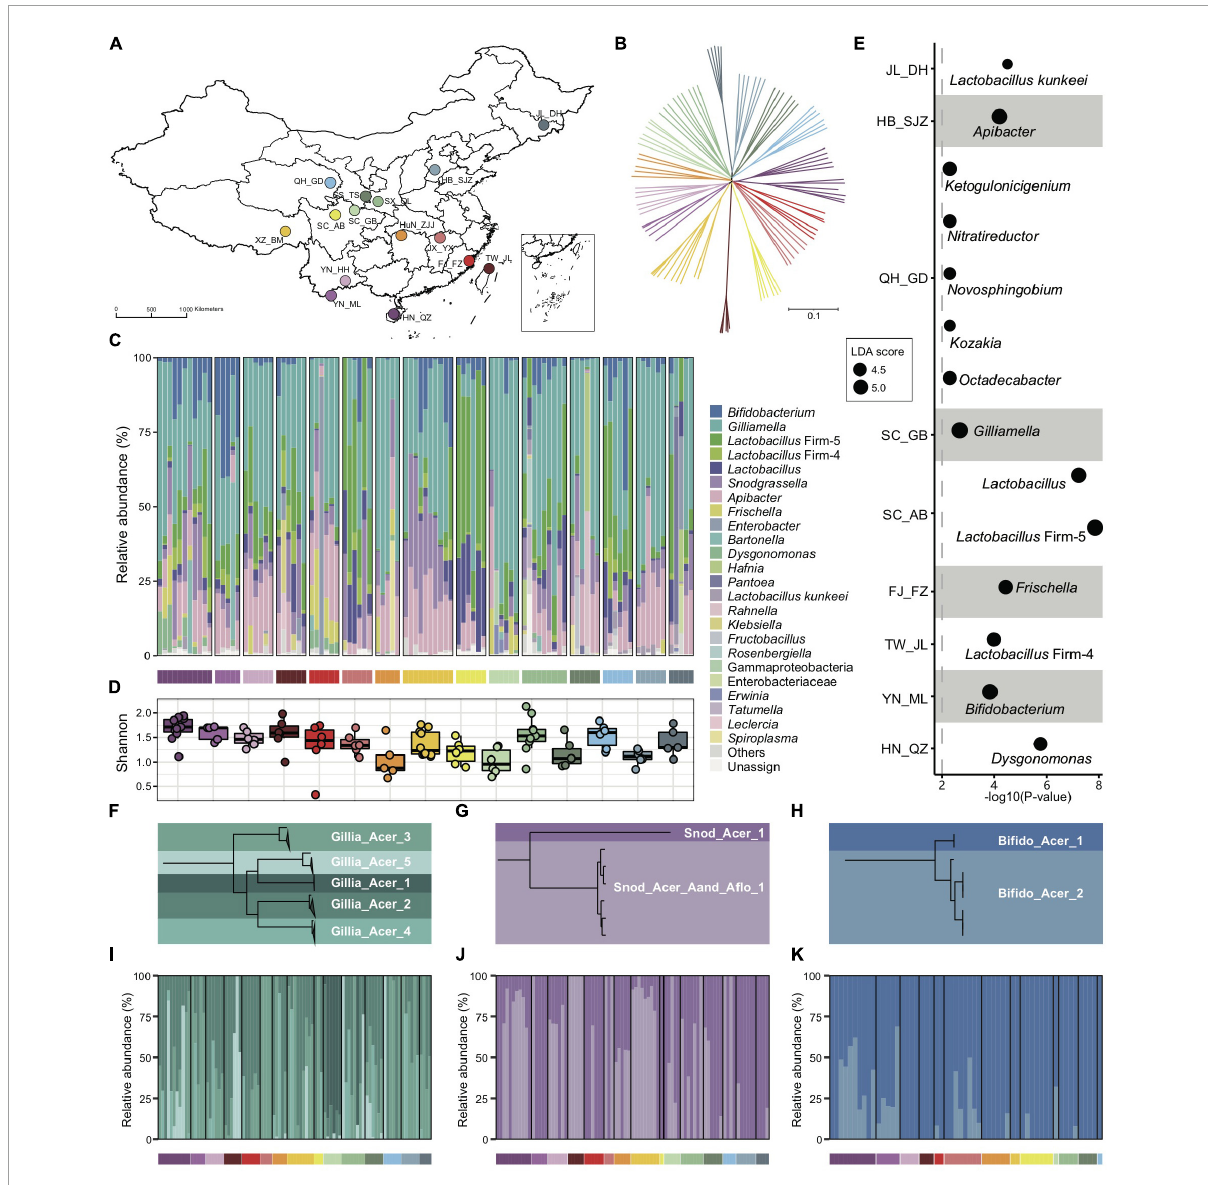
FIGURE1 Bacterial composition of gut microbiota in geographic populations of Apis cerana . (A) Sampling sites of 15 A. cerana geographic populations. (B) Neighbor-joining tree reflecting the honeybee population structure, based on genome-wide SNPs. Bacterial relative abundance (C) and Shannon index (D) are based on gut metagenomes of different populations. Phylotypes with at least 5% abundance in any sample or 0.5% abundance in more than 6 samples were shown, otherwise included in “Others.” Lactobacillus : Lactobacillus that is not assigned to any known groups. (E) Featured gut microbe phylotypes in each geographic population were revealed by LEfSe analyses. The size of the bubbles represents LDA score. Phylogenetic relationships of SDPs within Gilliamella (F) , Snodgrassella (G), and Bifidobacterium (H) . Maximal-likelihood phylograms, reconstructed using core genes present in all strains of the corresponding phylotype. The SDP compositions of Gilliamella (I) , Snodgrassella (J) , and Bifidobacterium (K) in gut samples, with those of abundances < 1% excluded. Horizontal bars under panels (C,I–K) indicate population origins of the guts, with colors corresponding to those in (A,B)